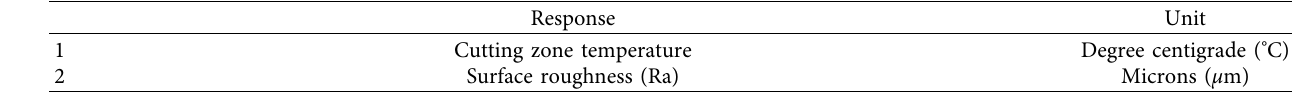
Table 3: DOE: response.